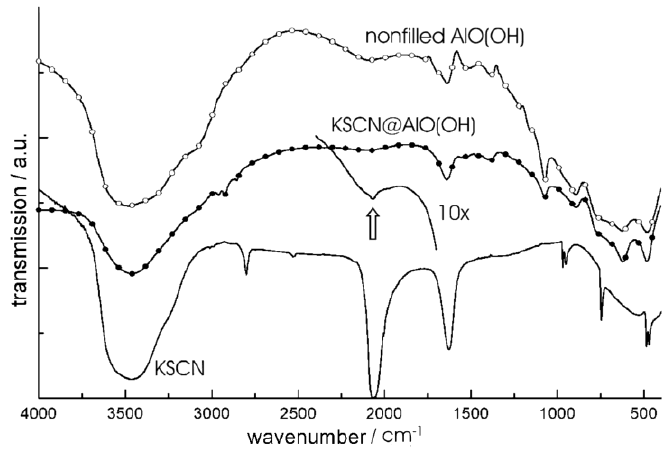
Figure 14. FT-IR spectra of KSCN@AlO(OH) with the vibration of [SCN]  indicated by arrows (spectra obtained with 1 mg and 10 mg (10x) of sample per 400 mg of KBr; spectra of nonfilled AlO(OH) hollow spheres and pure KSCN as references; modified reproduction from [24]).